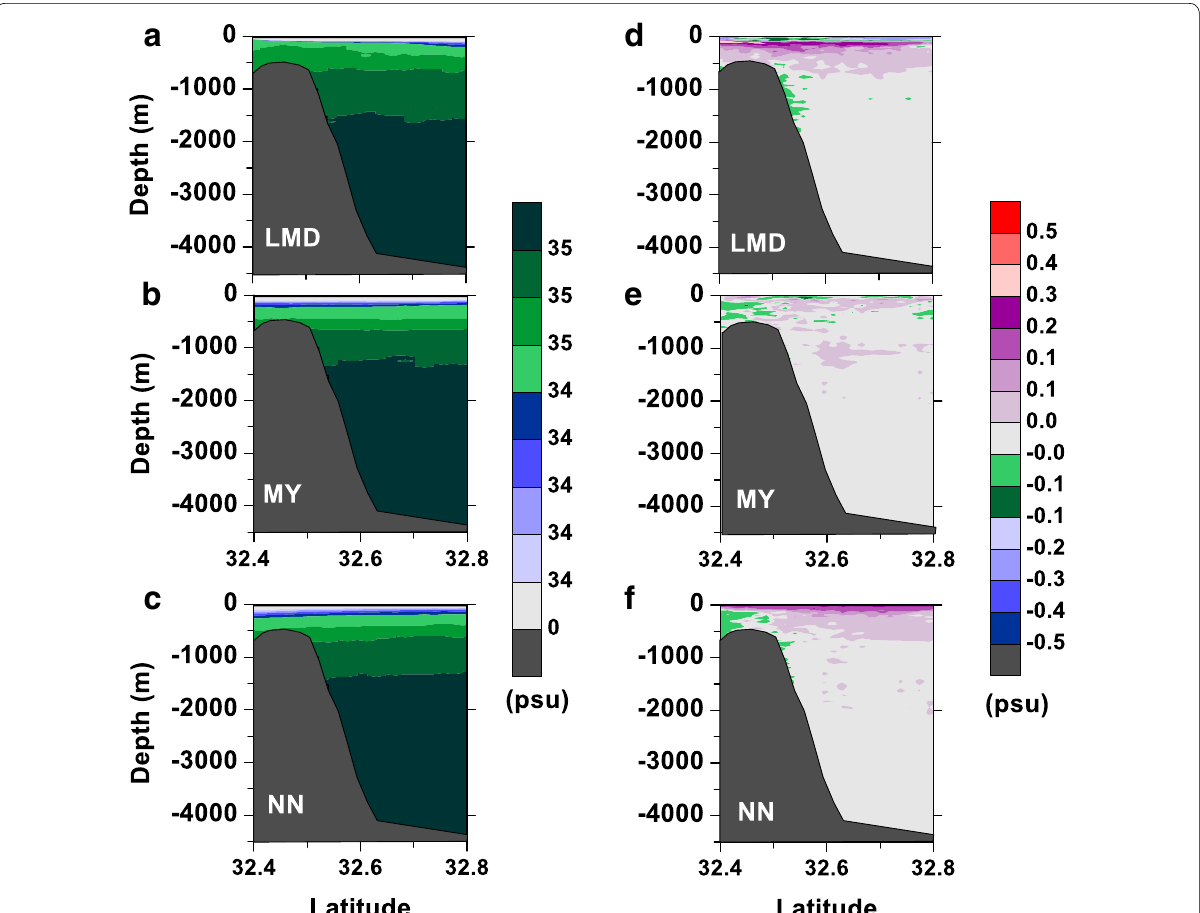
Fig. 11 The a – c salinities averaged over the last 5 days and the d – f difference between those averaged values and the initial values using the a , d LMD, b , e MY, and c , f NN vertical mixing